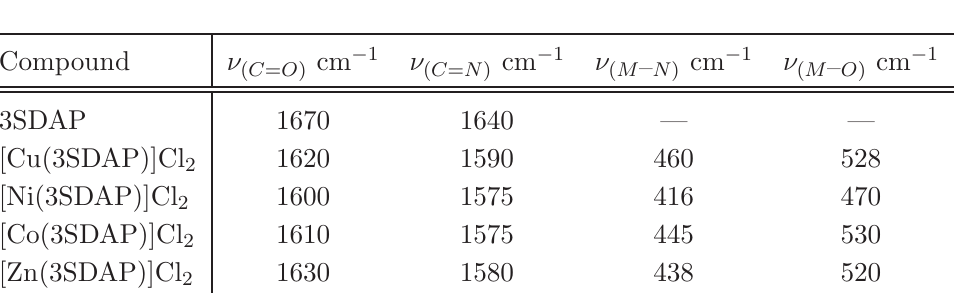
Table 2 IR spectral data of the synthesized